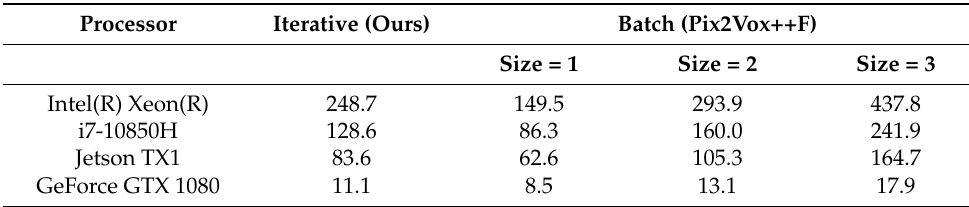
Table 5. Comparison of processing time for a single 3D reconstruction, reported in miliseconds and measured on various hardware platforms. Results are averages over reconstructions of 100 objects, with 20 images per